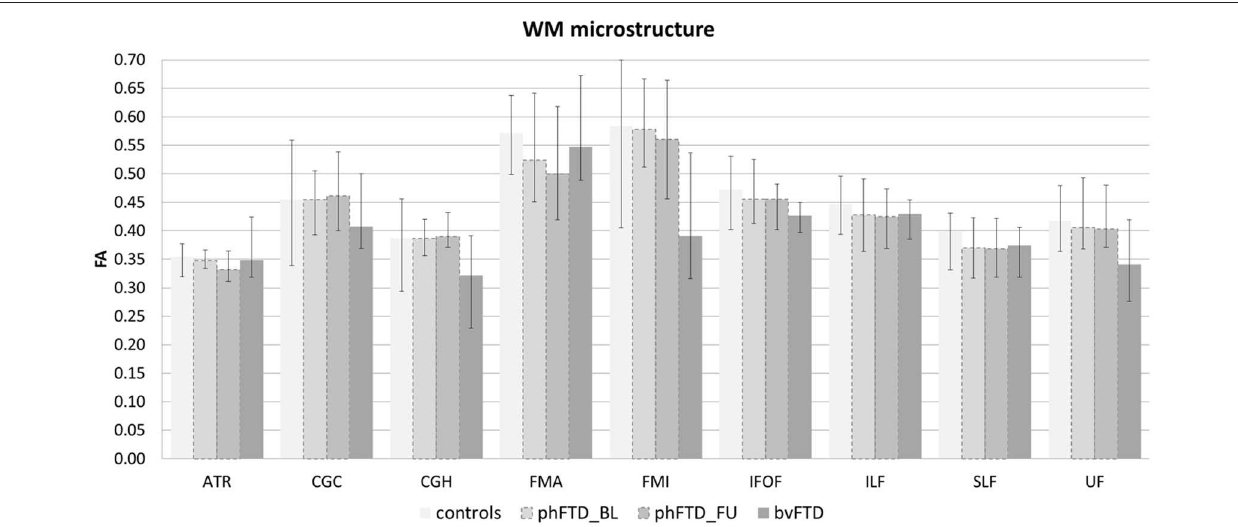
FIGURE 3 | White matter (WM) microstructure represented by fractional anisotropy (FA) per WM tract shown for each group (controls, baseline phFTD, follow-up phFTD, bvFTD). The range of FA is indicated by a minimum-maximum bar. WM tracts included are the bilateral anterior thalamic radiation (ATR), bilateral cingulate cingulum (CGC), bilateral hippocampal cingulum (CGH), forceps major (FMA), forceps minor (FMI), bilateral inferior fronto-occipital fasciculus (IFOF), bilateral inferior longitudinal fasciculus (ILF), bilateral superior longitudinal fasciculus (SLF), and bilateral uncinate fasciculus (UF). bvFTD, behavioral variant frontotemporal dementia; phFTD, phenocopy frontotemporal dementia; BL, baseline; FU,